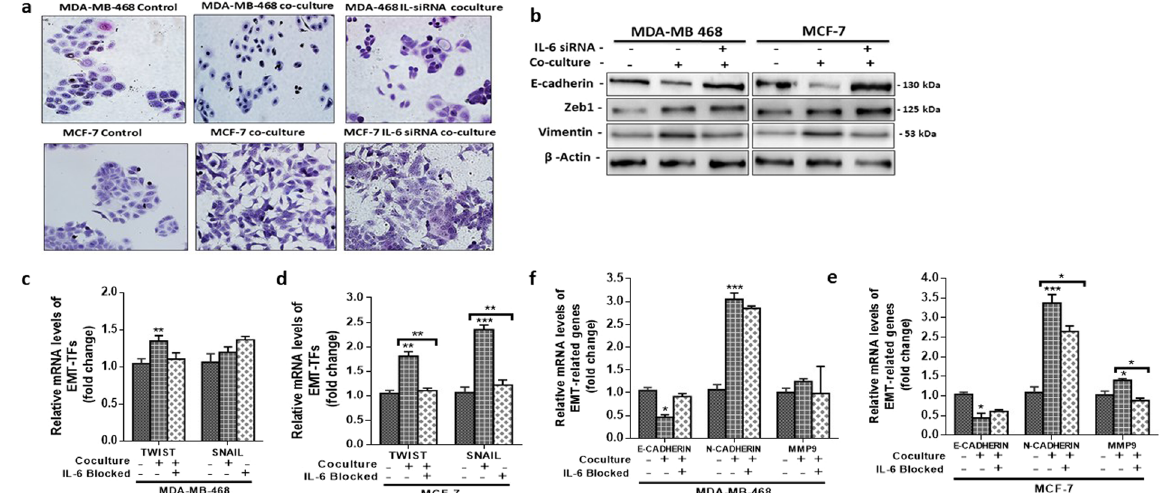
Figure 7. Expression of EMT-related genes was reversed after blocking IL-6 signalling. ( a ) Morphological characteristics of co-cultured breast cancer cell with/without IL-6 blocking and control breast cancer cells. ( b ) Western blot for e-cadherin, vimentin and ZEB1 in co-cultured breast cancer cells with/without IL-6 blocking and in control cells. Full-length blots are presented in Supplementary Fig. 5. ( c – f ) Quantitative PCR (qt- PCR) comparing the expression of EMT-TFs and EMT-related genes in co-cultured breast cancer cells with/ without IL-6 blocking and control cells. Relative mRNA expression was normalized to GAPDH. All results are representative of 3 independent experiments. (Data indicate mean ± SEM; *** p < 0,001; ** p < 0.01; * p <